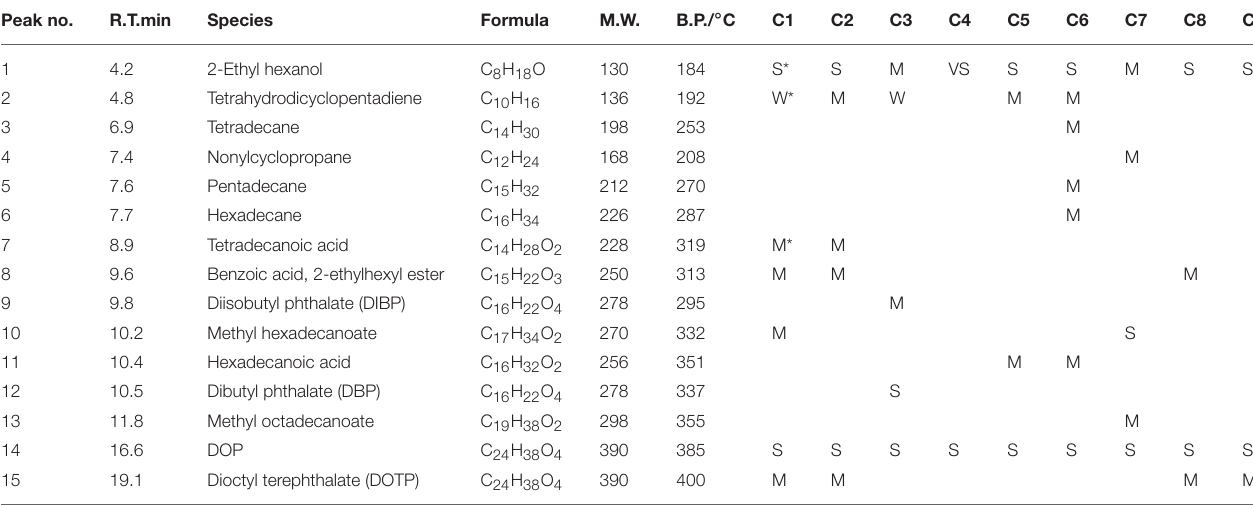
TABLE 2 | Compositions of cable 1–9 determined by the headspace GC-MS at a sample temperature of 200 ◦ C. Peak no.